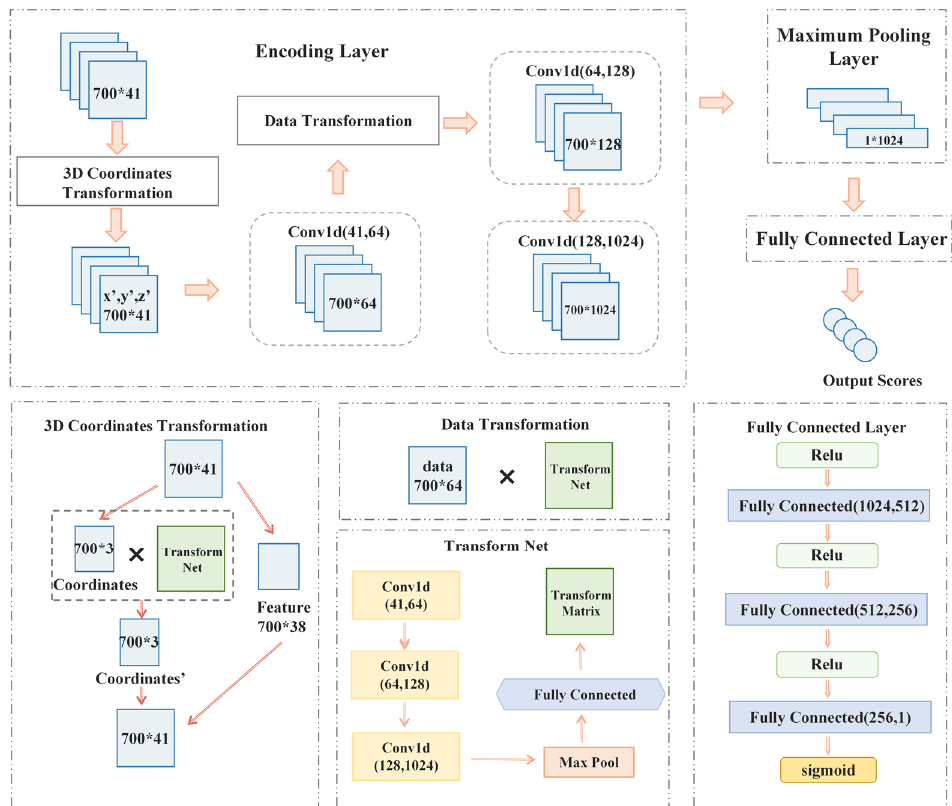
The deep architecture is shown in Figure 3.